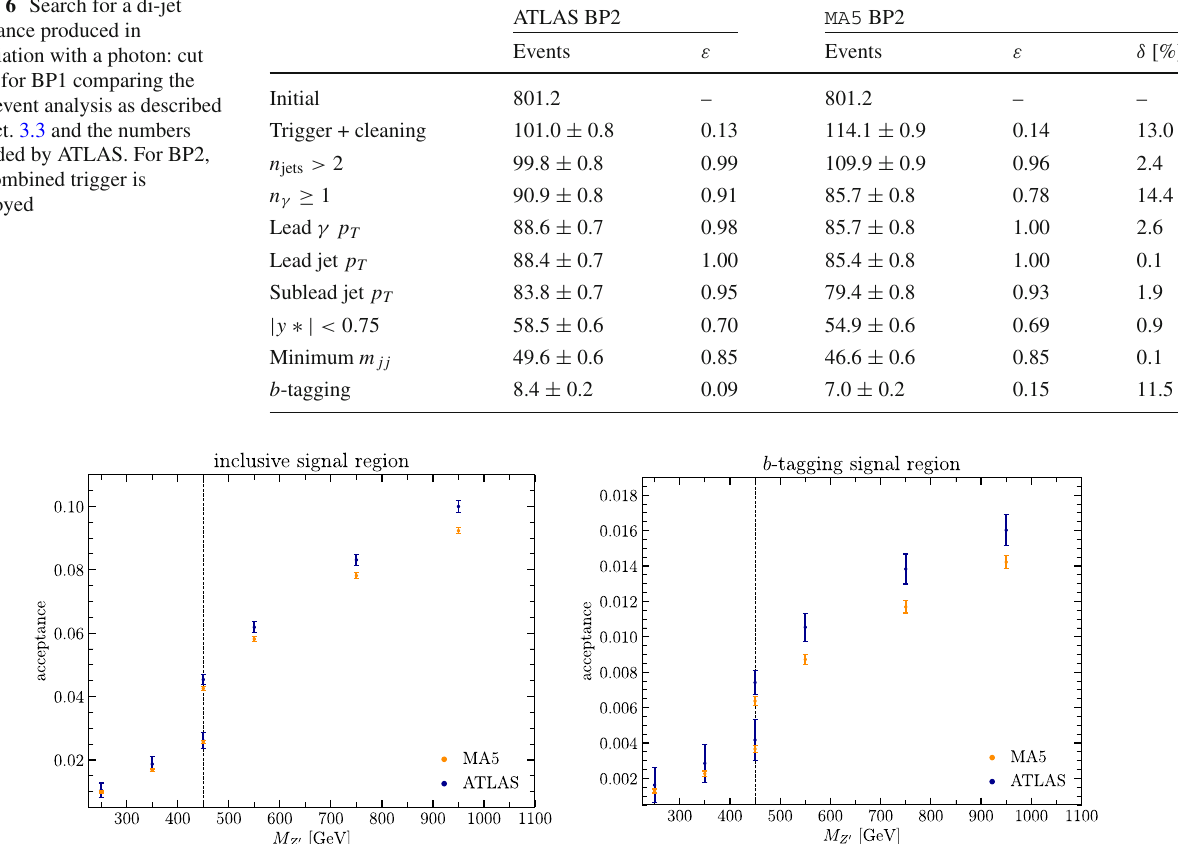
Fig. 7 Comparison of the acceptance values given in Ref. [28] to the values derived with our MA5 implementation. Left: inclusive signal region. Right: b -tagged signal region